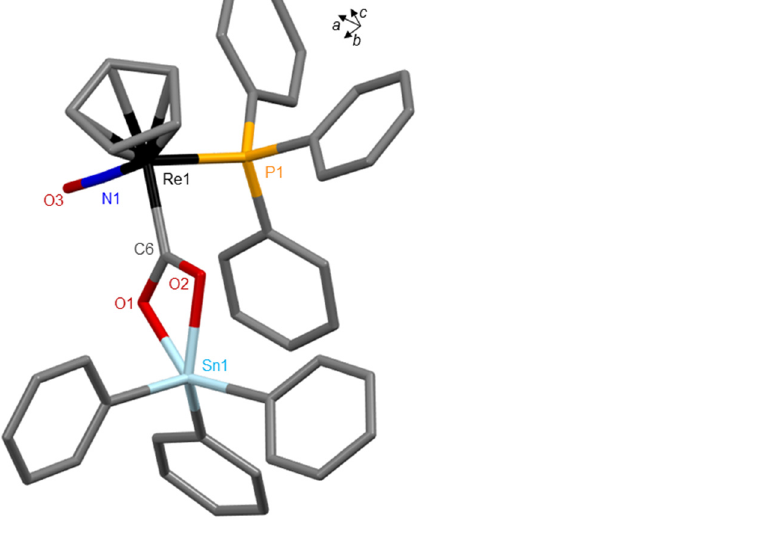
Figure 19. Molecular structure of 16 , adapted from [72] (MERCURY view). Hydrogen atoms are omitted for clarity (Sn light blue, O red, P orange, N dark blue, Re black, C grey). In 1991, Gibson et al. published the solid state structure of ( η - C 5 H 5 )Fe(CO)(PPh 3 )(CO 2 SnPh 3 ) ( 17 ) prepared by mixing, under nitrogen and at low tem- perature, Ph 3 SnCl to a THF solution of CpFe(CO)(PPh 3 )COOK·3H 2 O [73]. The structure